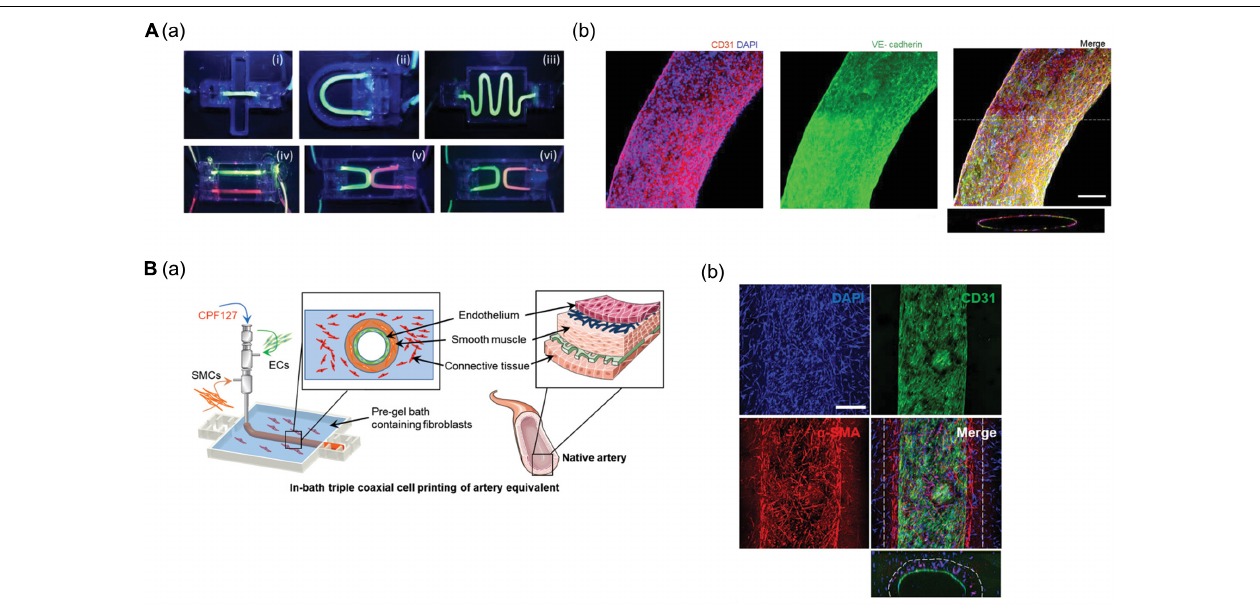
FIGURE 1 | (A) Construction of perfusable and functional in vitro vascular models using co-axial cell printing. (a) Fabrication of various patterns of in vitro vascular models is demonstrated by perfusion of fluorescent dyes. (b) Expression of the cell-cell junction marker VE-cadherin is confirmed on day 7 in the printed vessels, indicating maturation of the vessels. Reprinted with permission from Gao et al. (2018). (B) Formation of triple-layered vascular model via in-bath triple co-axial cell printing. (a) Schematic describes printing procedure to produce triple-layered vascular model. (b) Immunofluorescence images show multi-layered blood vessels with endothelial cells (CD31) on the inside and surrounded by smooth muscle cells ( α -SMA). Reprinted with permission from Gao et al. (2020).